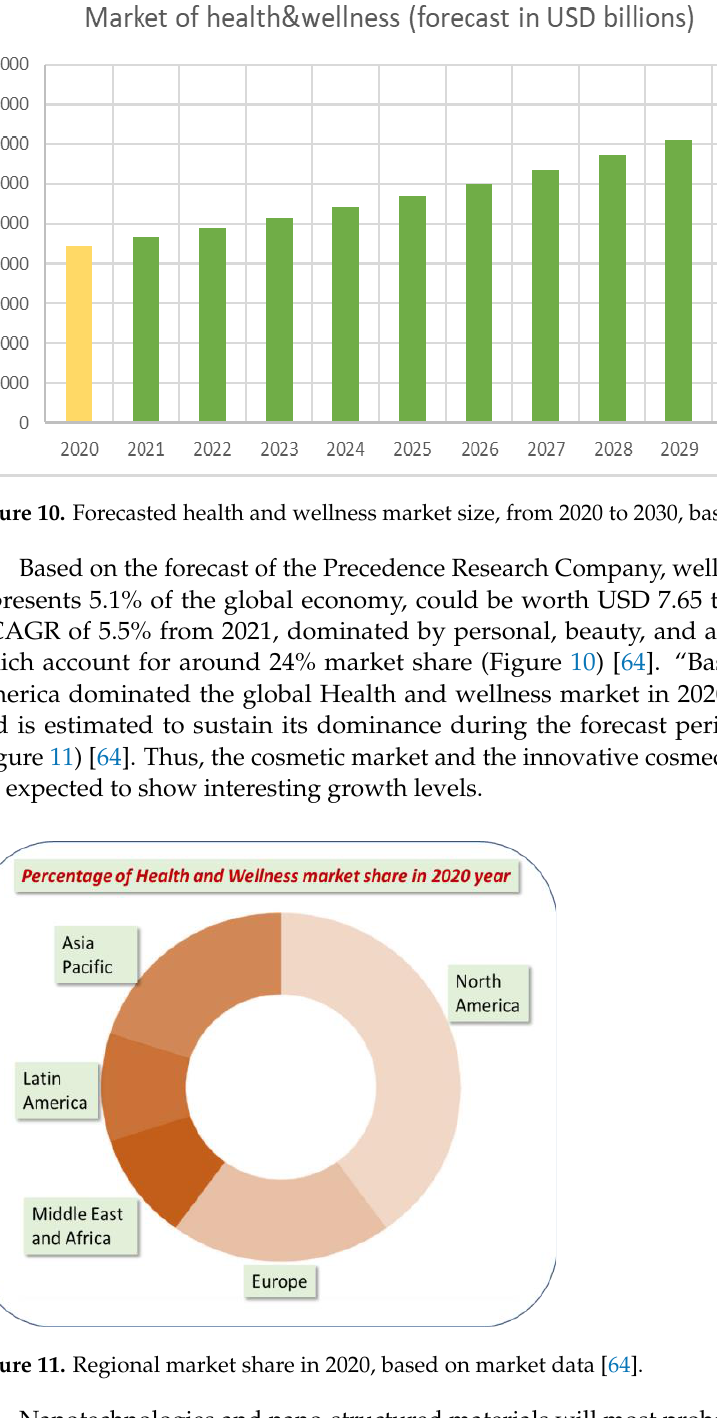
Figure 11. Regional market share in 2020, based on market data [64].